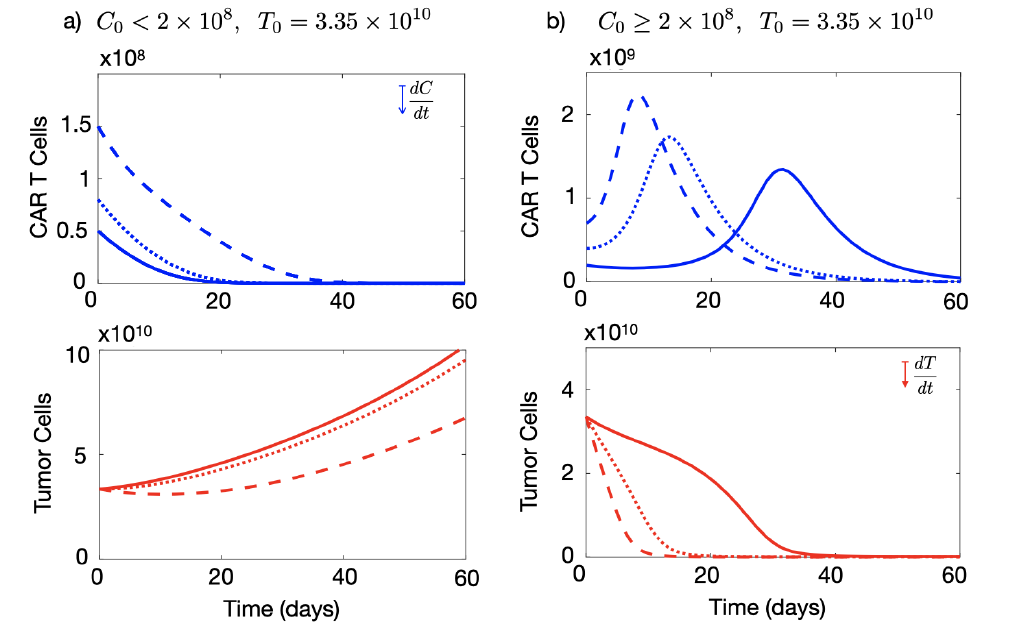
Figure 3. Injection of large numbers of CAR-T cells allows immune suppression effects of solid tumours to be overcome in silico. Longitudinal dynamics of the total number of CAR-T (blue) and tumour cells (red) ruled by Equations (1) and (2). The curves correspond to different values of CAR-T cells injected into a patient bearing a number of T 0 = 3.35 × 10 10 tumour cells. ( a ) CAR-T cell dynamics for C 0 = 5 × 10 7 (solid line), C 0 = 8 × 10 7 (dotted line), C 0 = 1.5 × 10 8 (dashed line). ( b ) Longitudinal dynamics of the CAR-T cells for C 0 = 2 × 10 8 (solid line), C 0 = 4 × 10 8 (dotted line) and C 0 = 7 × 10 8 (dashed line). The parameter values used in the simulations were τ C = 7 days, ρ C = 0.9 day − 1 , ρ T = 1/50 day − 1 , α 1 = 0.04 day − 1 cell − 1 , α 2 = 2.5 × 10 − 10 day − 1 cell − 1 , g T = 10 10 and g C = 2 × 10 9